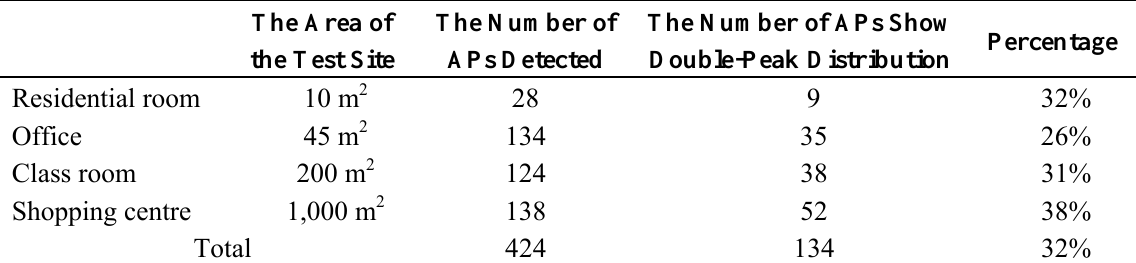
Table 1. Double-peak distribution of RSSs in